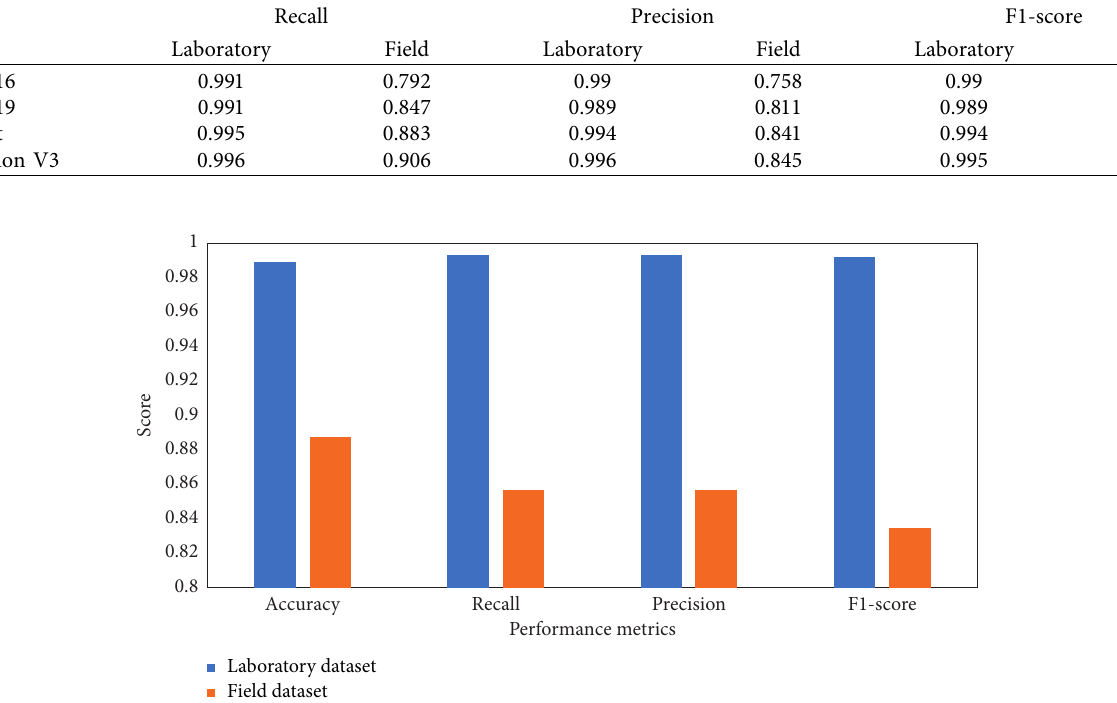
Figure 1: Summary of performance on laboratory- and field-based datasets.